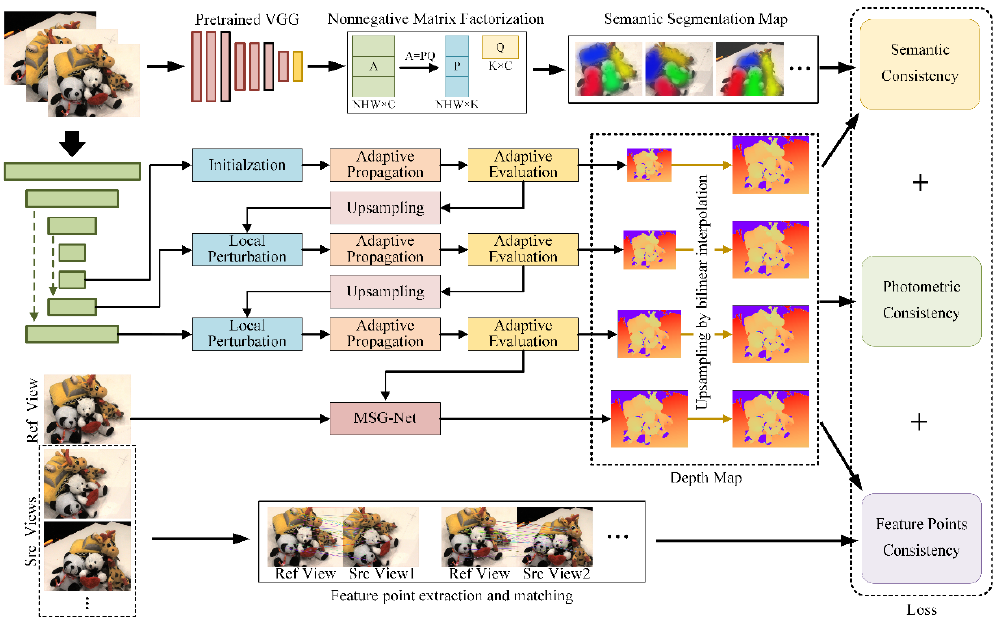
Figure 1. The network structure of Unsup_patchmatchnet.